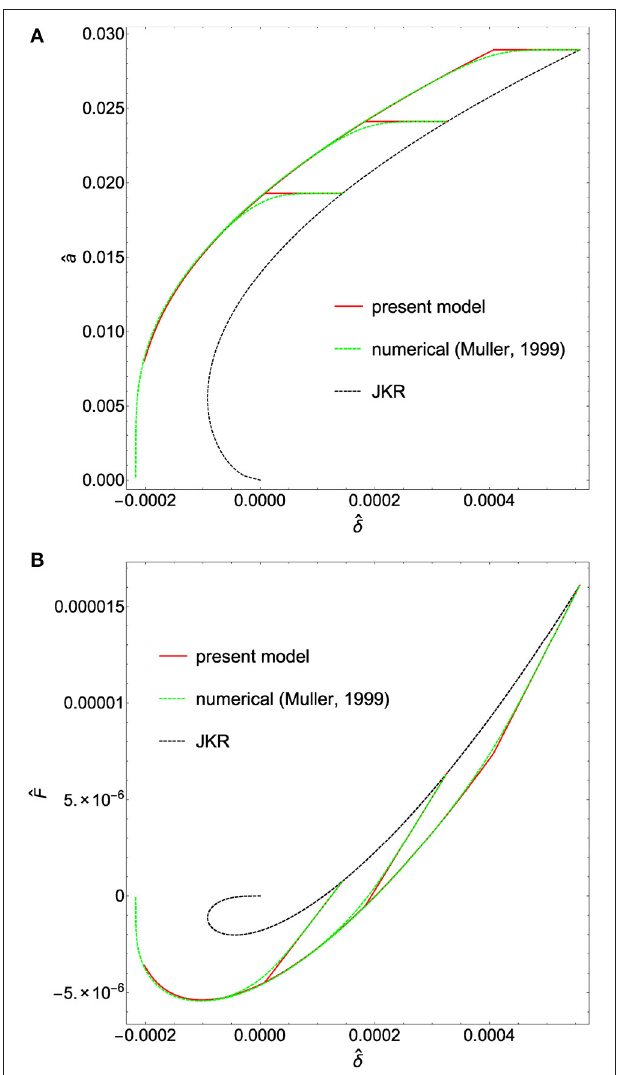
FIGURE 5 | The predicted pull-off force ˆ F pull − off,VL , normalized with respect to JKR’s one ( ˆ F pull − off,JKR = 1.5 π1 ˆ γ ), as a function of the dimensionless driving velocity ˆ V . Blue diamonds refer to experimental data, while red circles to theoretical predictions. Black dashed line denotes the predictions of the empirical Equation (19).